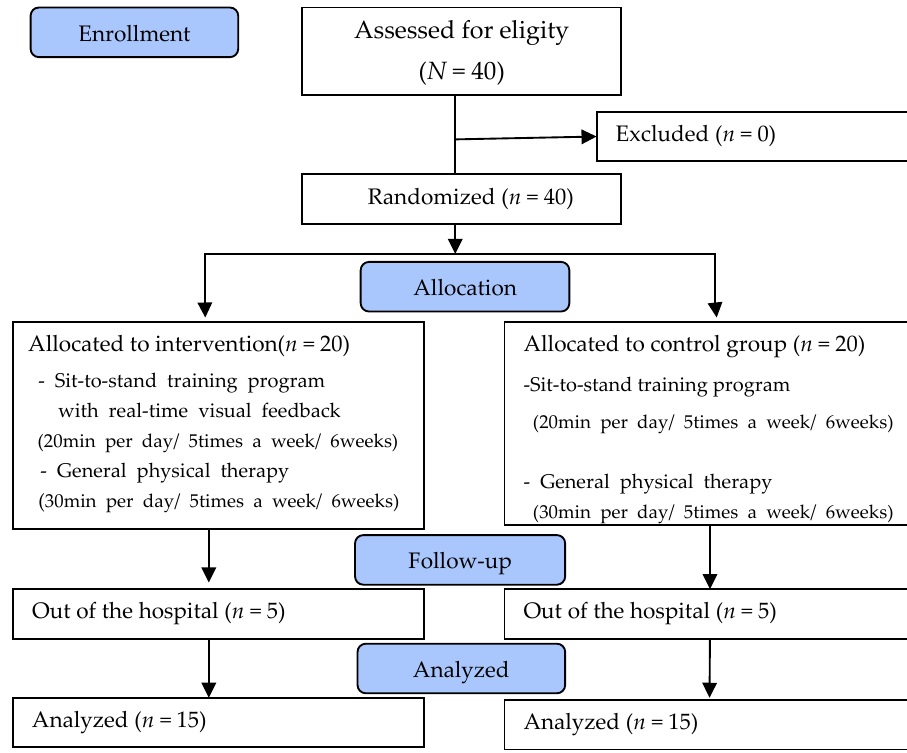
Figure 1. Flow diagram of total experimental procedure.